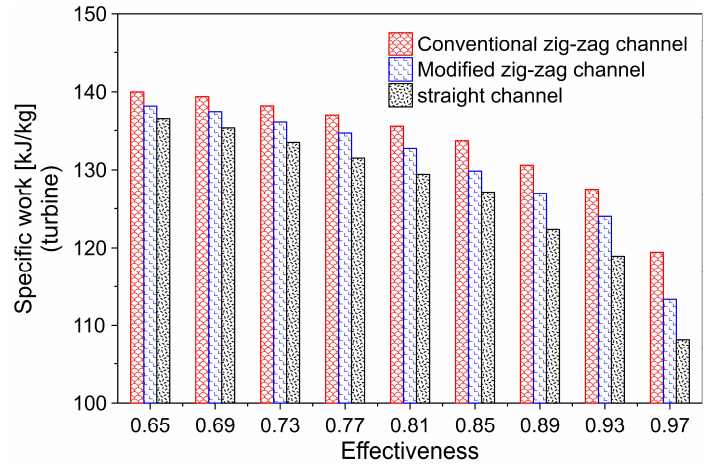
Figure 19. Specific work by the supercritical Brayton cycle turbine.